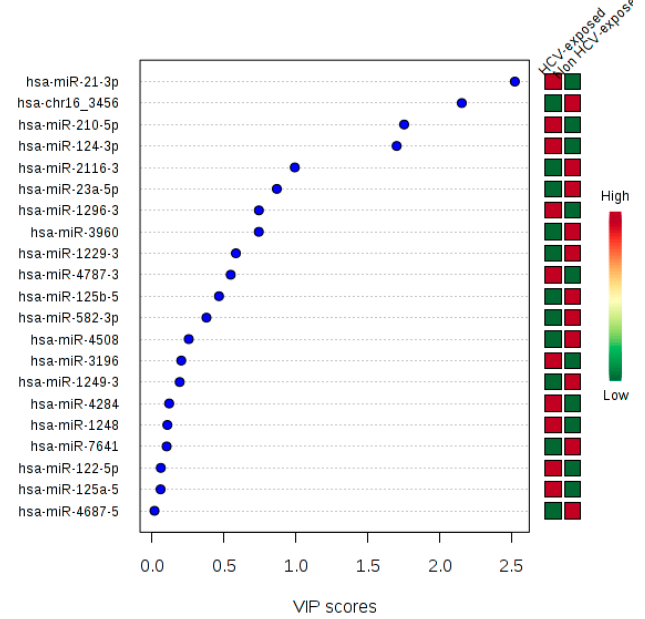
Figure 5. Variable Importance in Projection (VIP) calculated for each 21 SDE miRNAs.